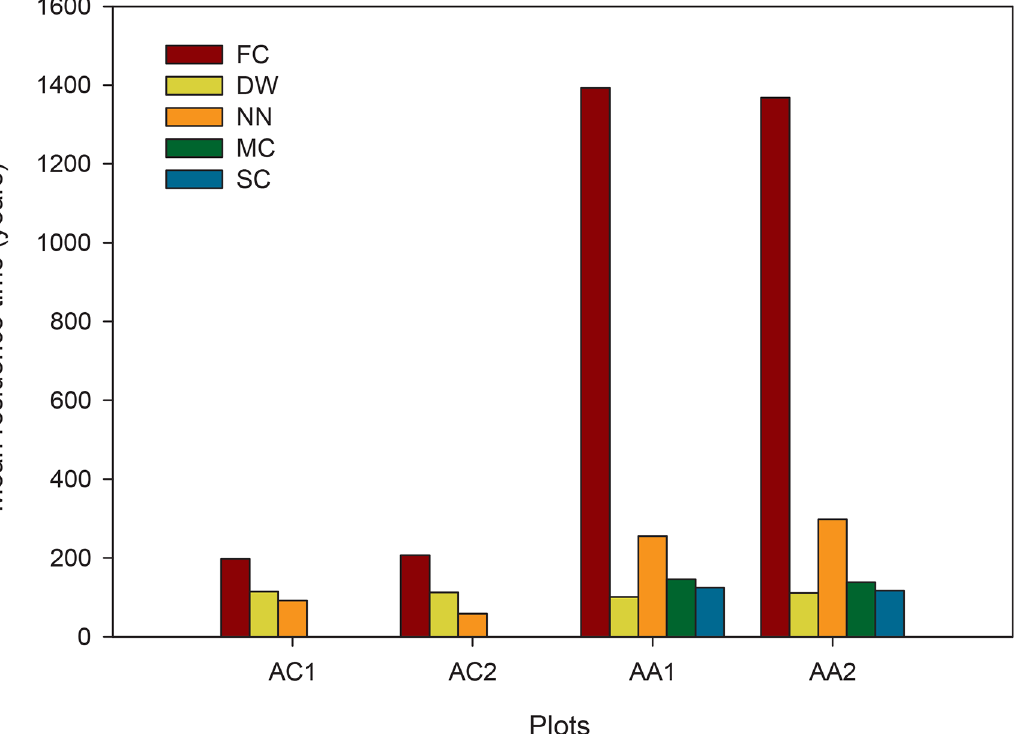
Fig 6. Mean wood residence time per species and plot. Mean wood residence time for the main species in each plot. FC: Fitzroya cupressoides , NN: Nothofagus nitida , DW: Drimys winteri , MC: Myrceugenia chrysocarpa , SC: Saxegothaea conspicua